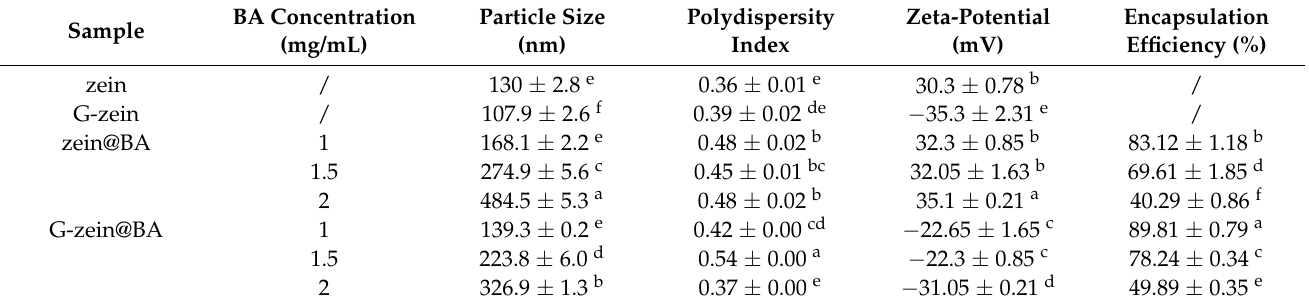
Table 1. The effect of betulinic acid (BA) concentration on zein@BA and G-zein@BA nanoparticle